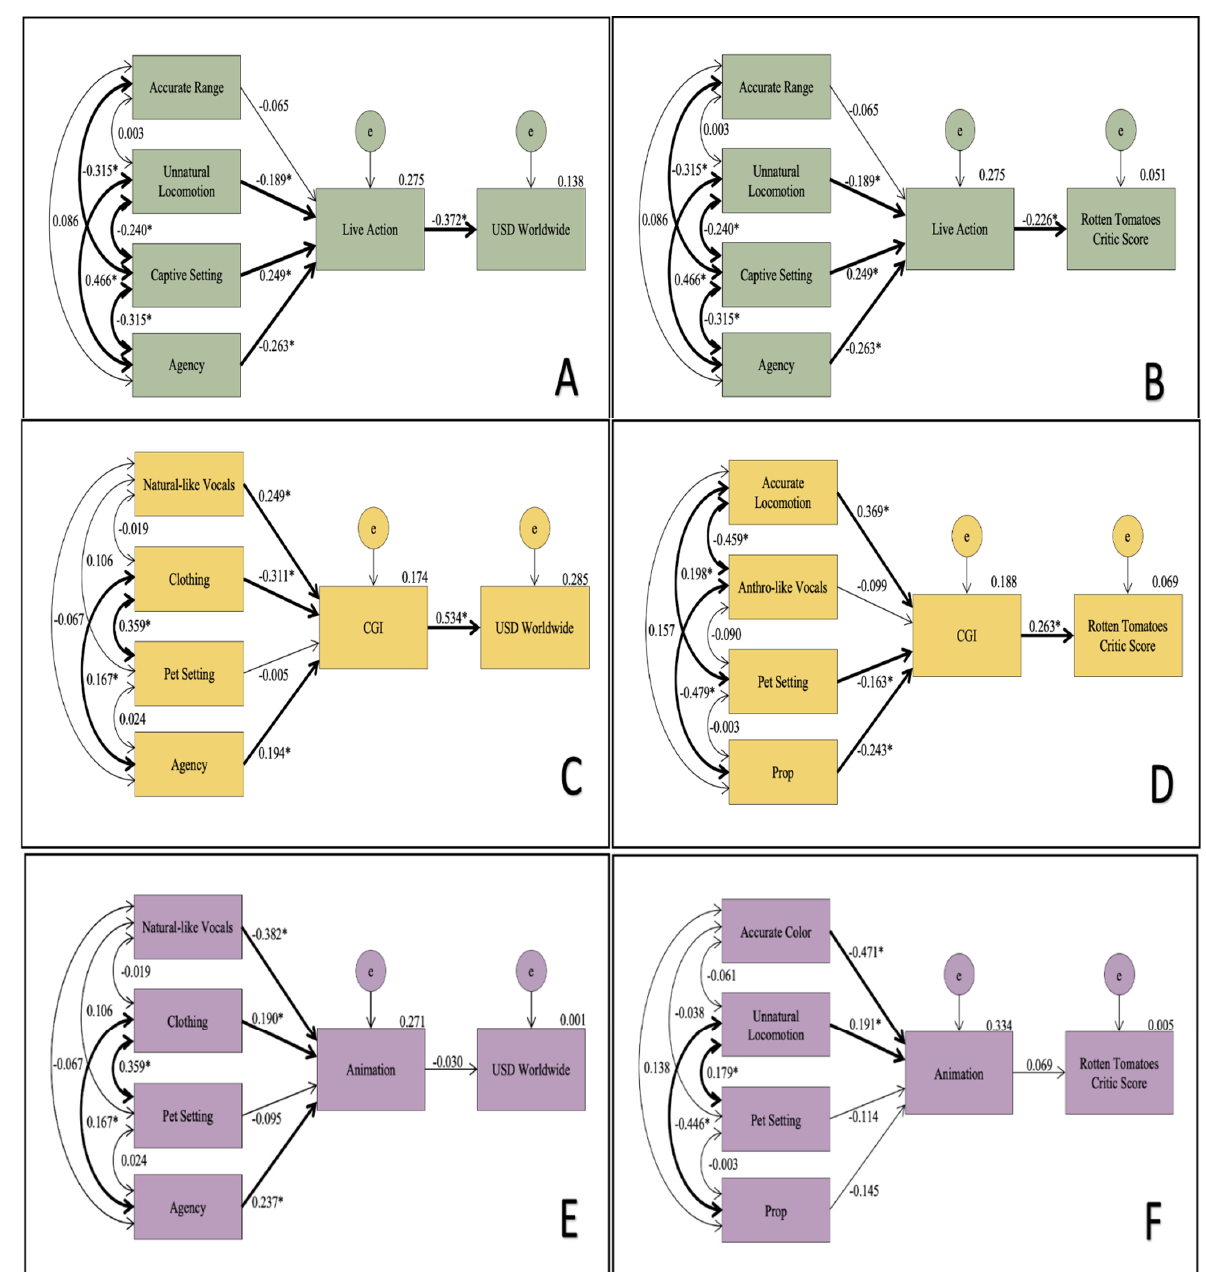
Figure 3. Path-analysis models for live-action, CGI and animation medium. Model A ( χ 2 (4) = 1.693; p = 0.792; CFI = 1.000; RMSEA = 0.000) represents the most probable factors to predict the use of live-action primates based on the relationship with the film’s gross profit worldwide in USD. Model B ( χ 2 (4) = 2.067; p = 0.723; CFI = 1.000; RMSEA = 0.000) represents the most probable factors to predict the use of live primates based on the relationship with the film’s critic consensus scores from Rotten Tomatoes. Model C ( χ 2 (4) = 3.387, p = 0.495; CFI = 1.000; RMSEA = 0.000) represents the most probable factors to predict the use of animation based on its relationship with the film’s gross profit worldwide in USD. Model D ( χ 2 (4) = 3.608, p = 0.462 ; CFI = 1.000; RMSEA = 0.000) represents the most probable factors to predict the use of animation based on its relationship with the film’s critic consensus scores from Rotten Tomatoes. Model E ( χ 2 (4) = 1.823; p = 0.768 ; CFI = 1.000; RMSEA = 0.000) represents the most probable factors to predict the use of CGI based on its relationship with the film’s gross profit worldwide in USD. Model F ( χ 2 (4) = 2.026; p = 0.731; CFI = 1.000; RMSEA = 0.000) represents the most probable factors to predict the use of CGI based on its relationship with the film’s critic consensus scores from Rotten Tomatoes. Bolded arrows, paired with starred standardized regression weight or covariance, indicate a statistically significant relationship.